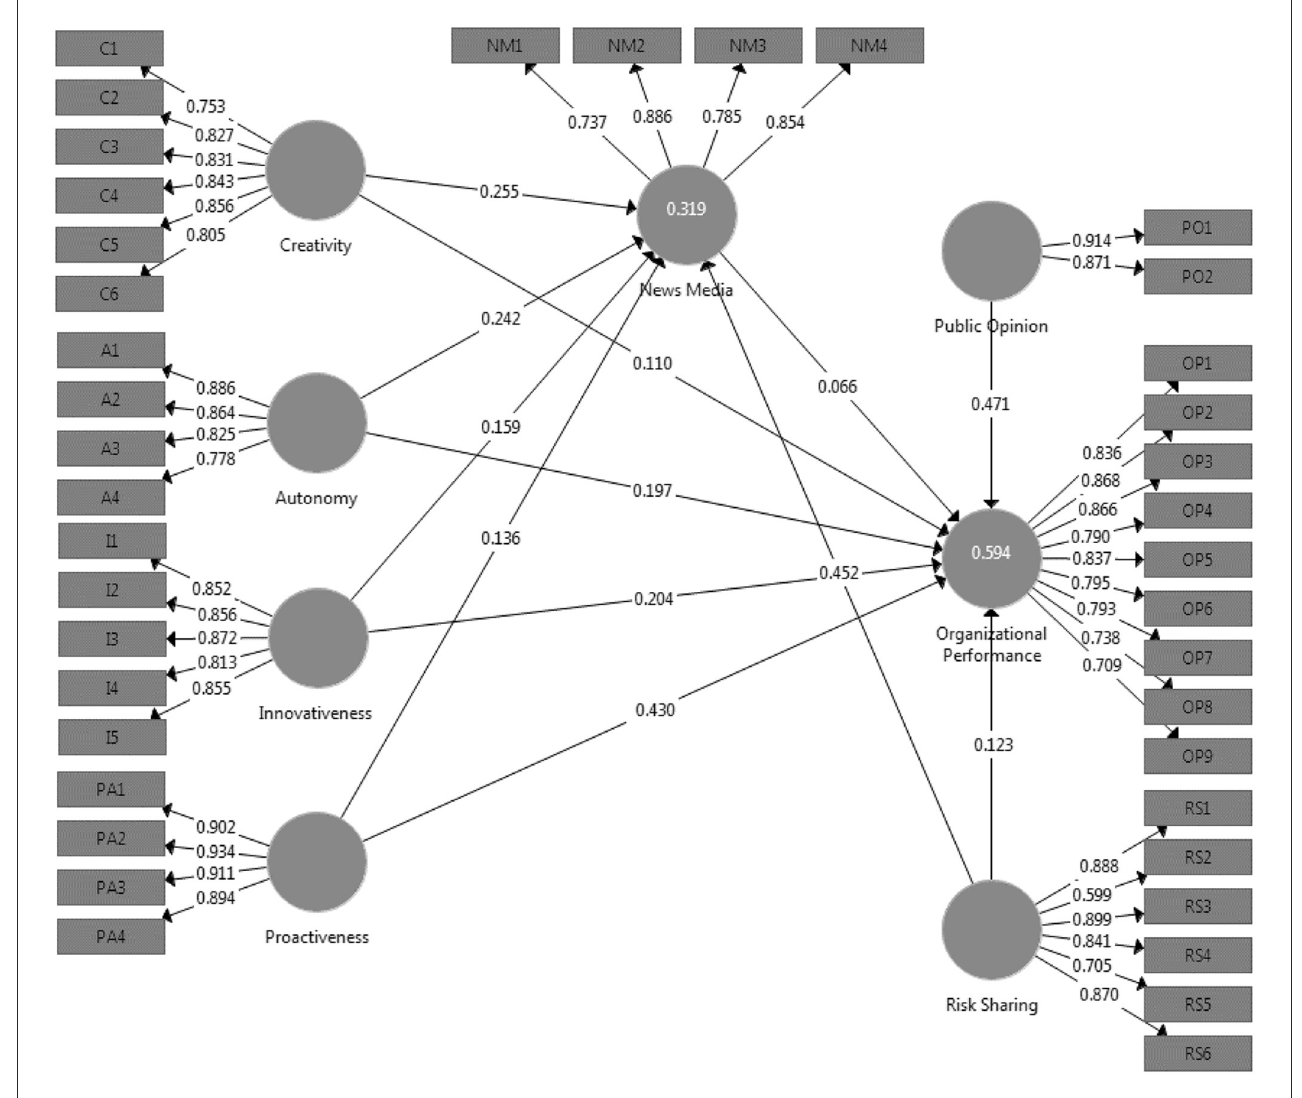
FIGURE3 Measurement model.